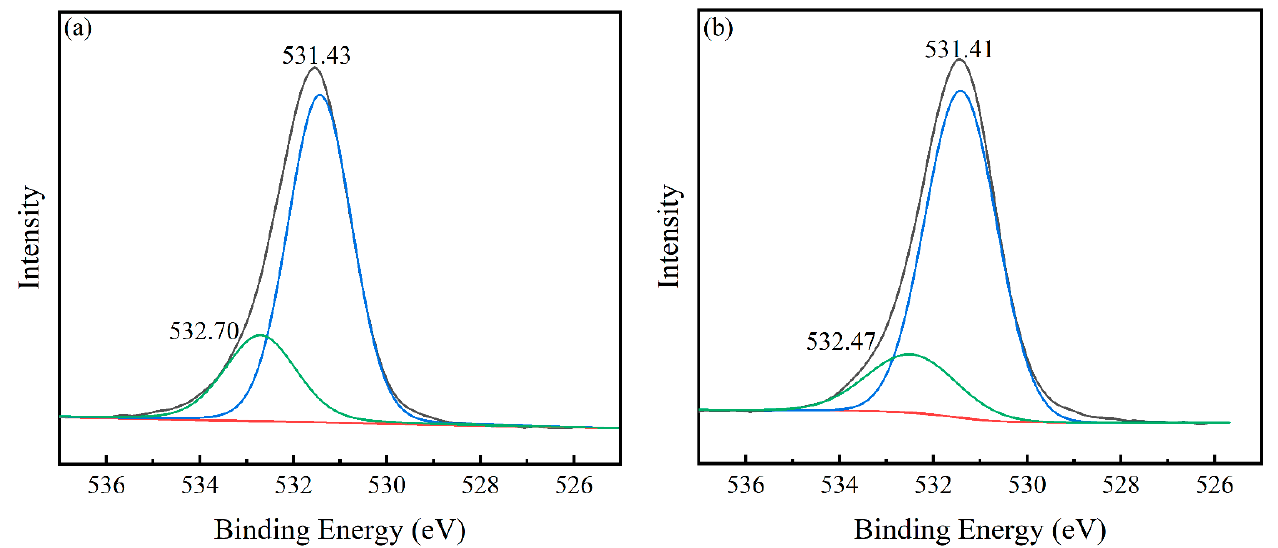
Figure 6. C1s XPS spectra of malachite surfaces as follows: ( a ) treated with Na 2 S, ( b ) treated with